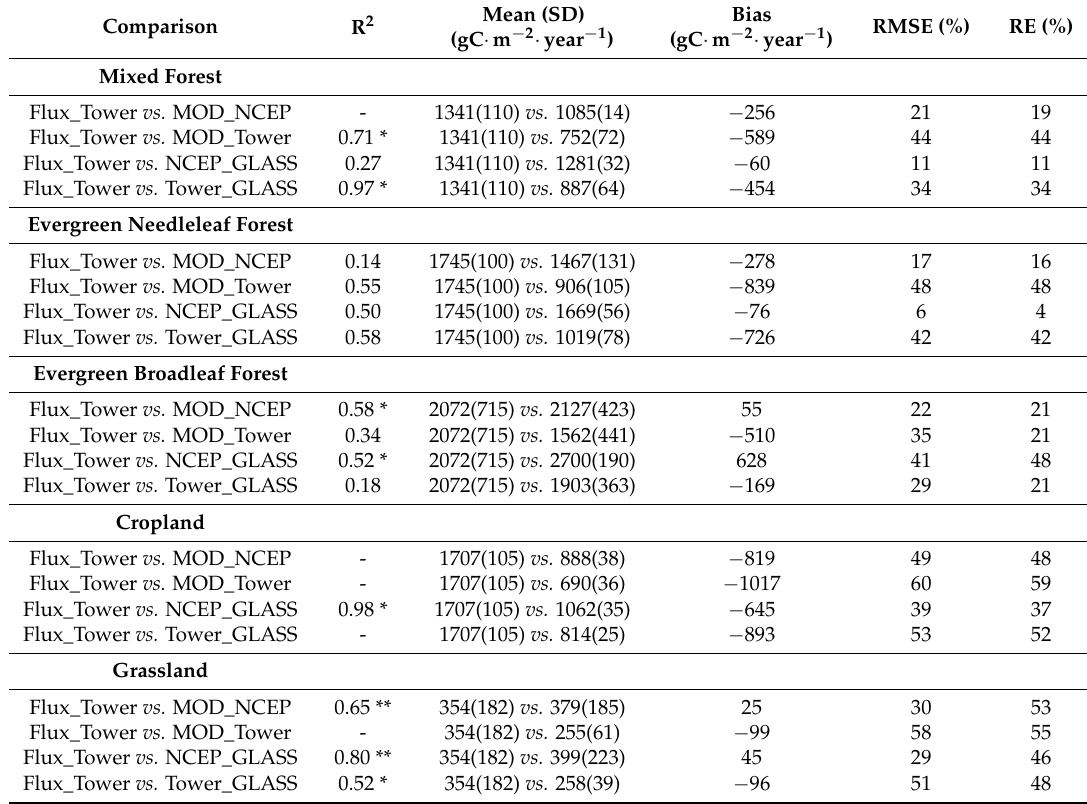
Table 4. Biome-based comparison of the annual GPP derived from the tower estimates with those derived from the MODIS algorithms (MOD_NCEP GPP, MOD_Tower GPP, NCEP_GLASS GPP, and Tower_GLASS